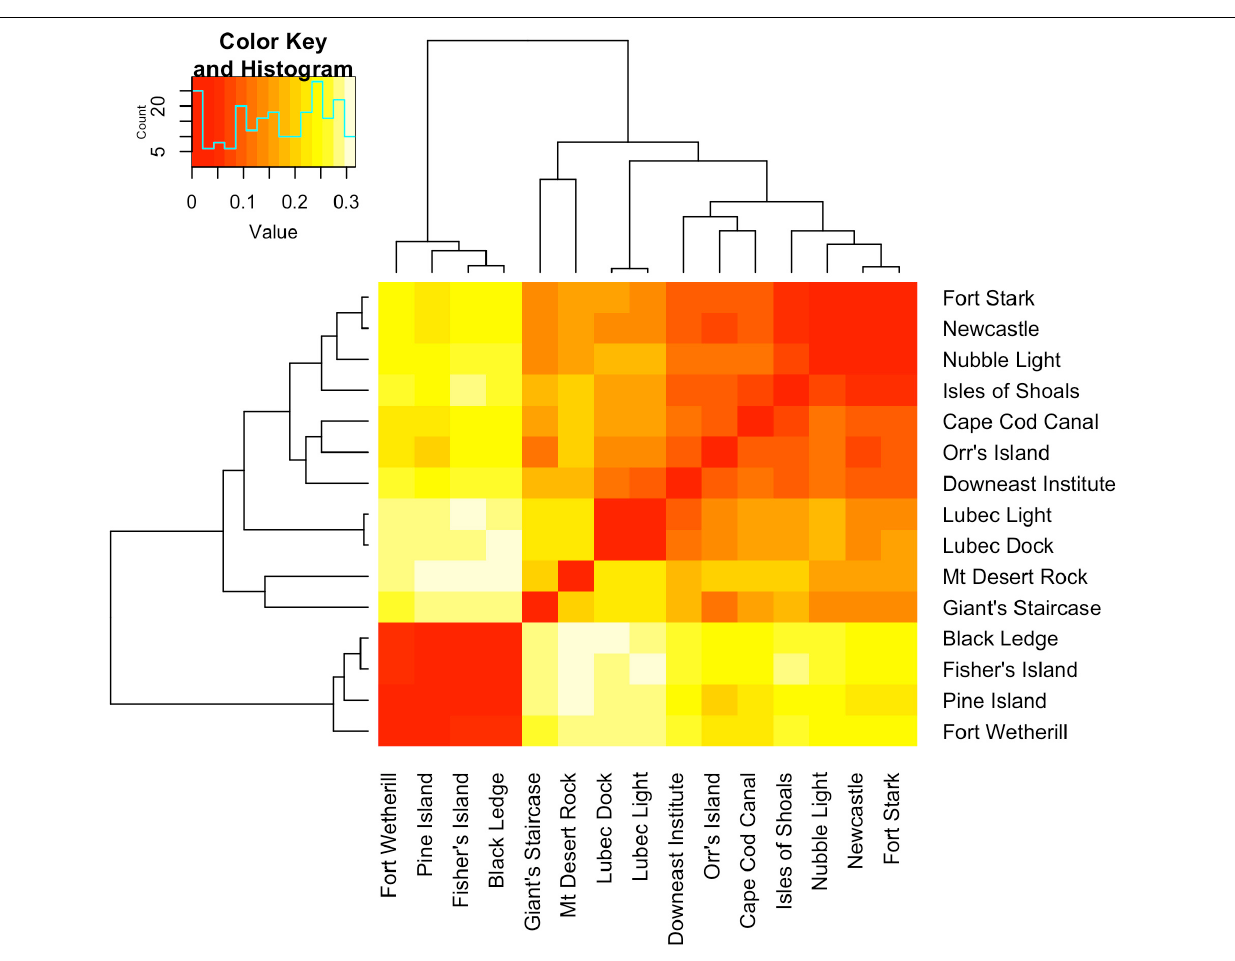
FIGURE 3 | Heat map showing pairwise F ST values with hierarchical clustering. Insert graph on the top left is a histogram showing the frequency spectrum of pairwise F ST